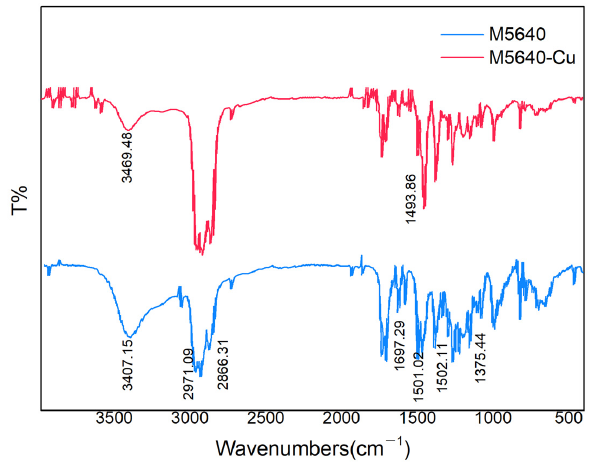
Figure 3. IR spectra of M5640 and